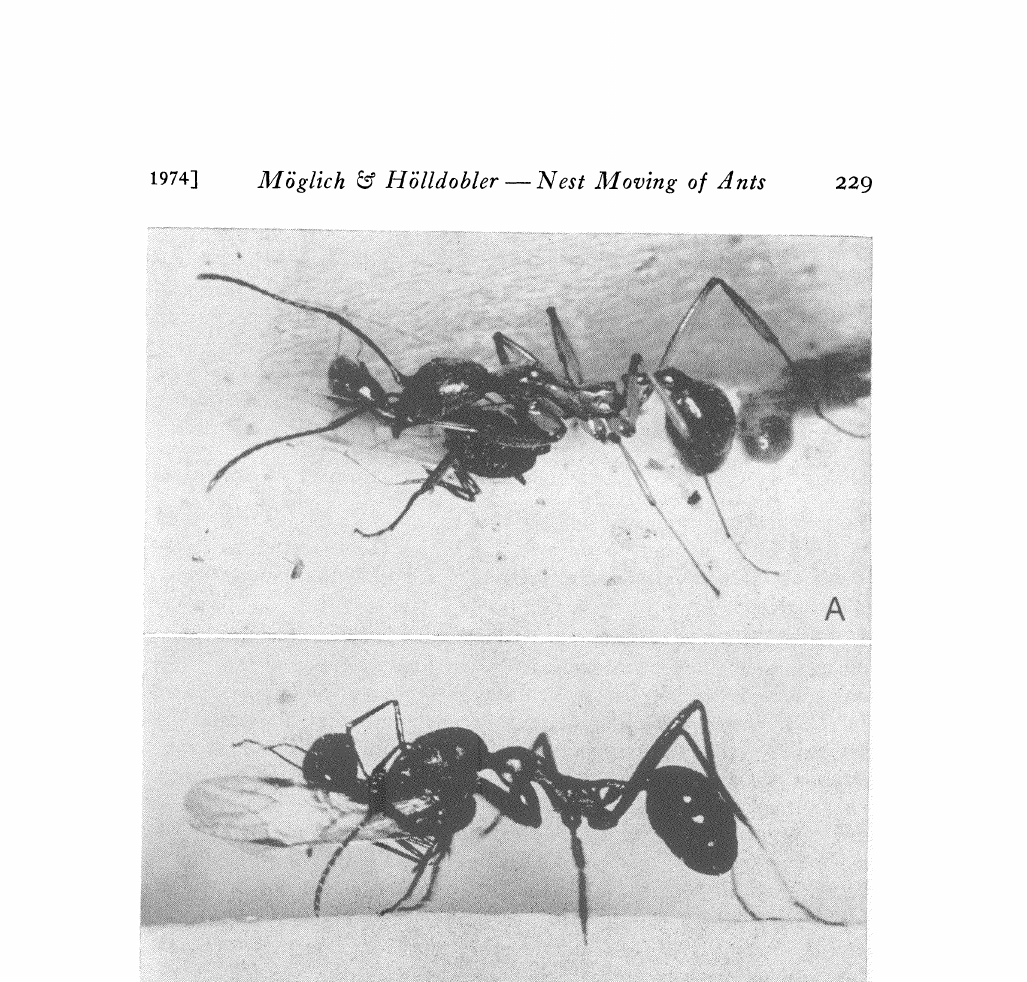
Fig. 7. Male transport in A) A phaenotTaster floridanus and B) Novo- messor